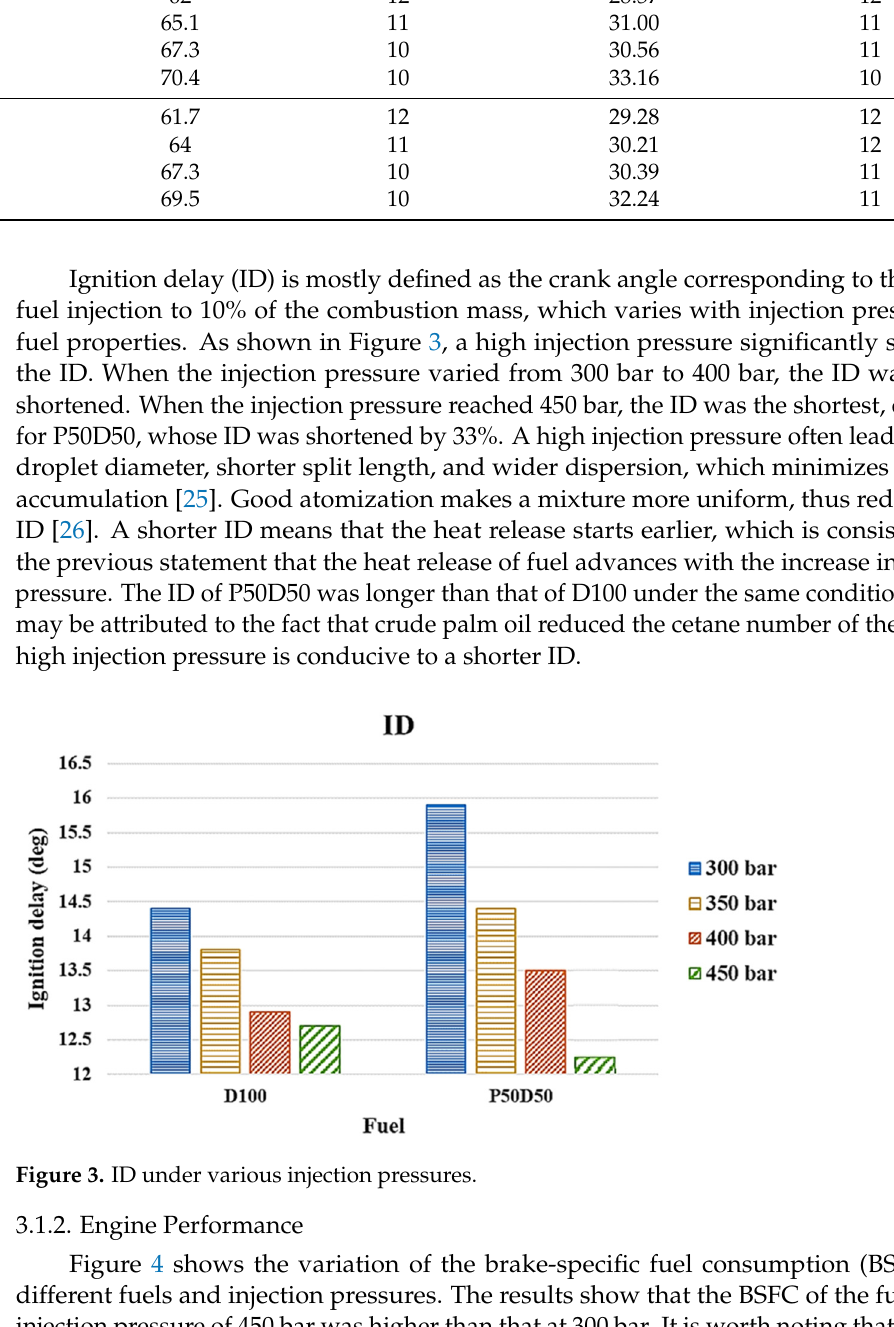
Figure 4. BSFC under various injection pressures. Brake thermal efficiency (BTE) is the reciprocal of the product of BSFC and the calo- rific value of the fuel, so the trends of BTE and BSFC are often opposite, as shown in pre- vious studies [27,28]. Figure 5 depicts the BTE of the test fuel under four injection pres- sures. It can be directly observed that the BTE of the same fuel was negatively correlated with the variation of BSFC. However, interestingly, the fuels with the best BSFC perfor- mance did not show the best BTE. Under the same operating conditions, D100 always exhibited the lowest BSFC, but at 350 and 400 bar, P50D50 had the highest efficiency. It